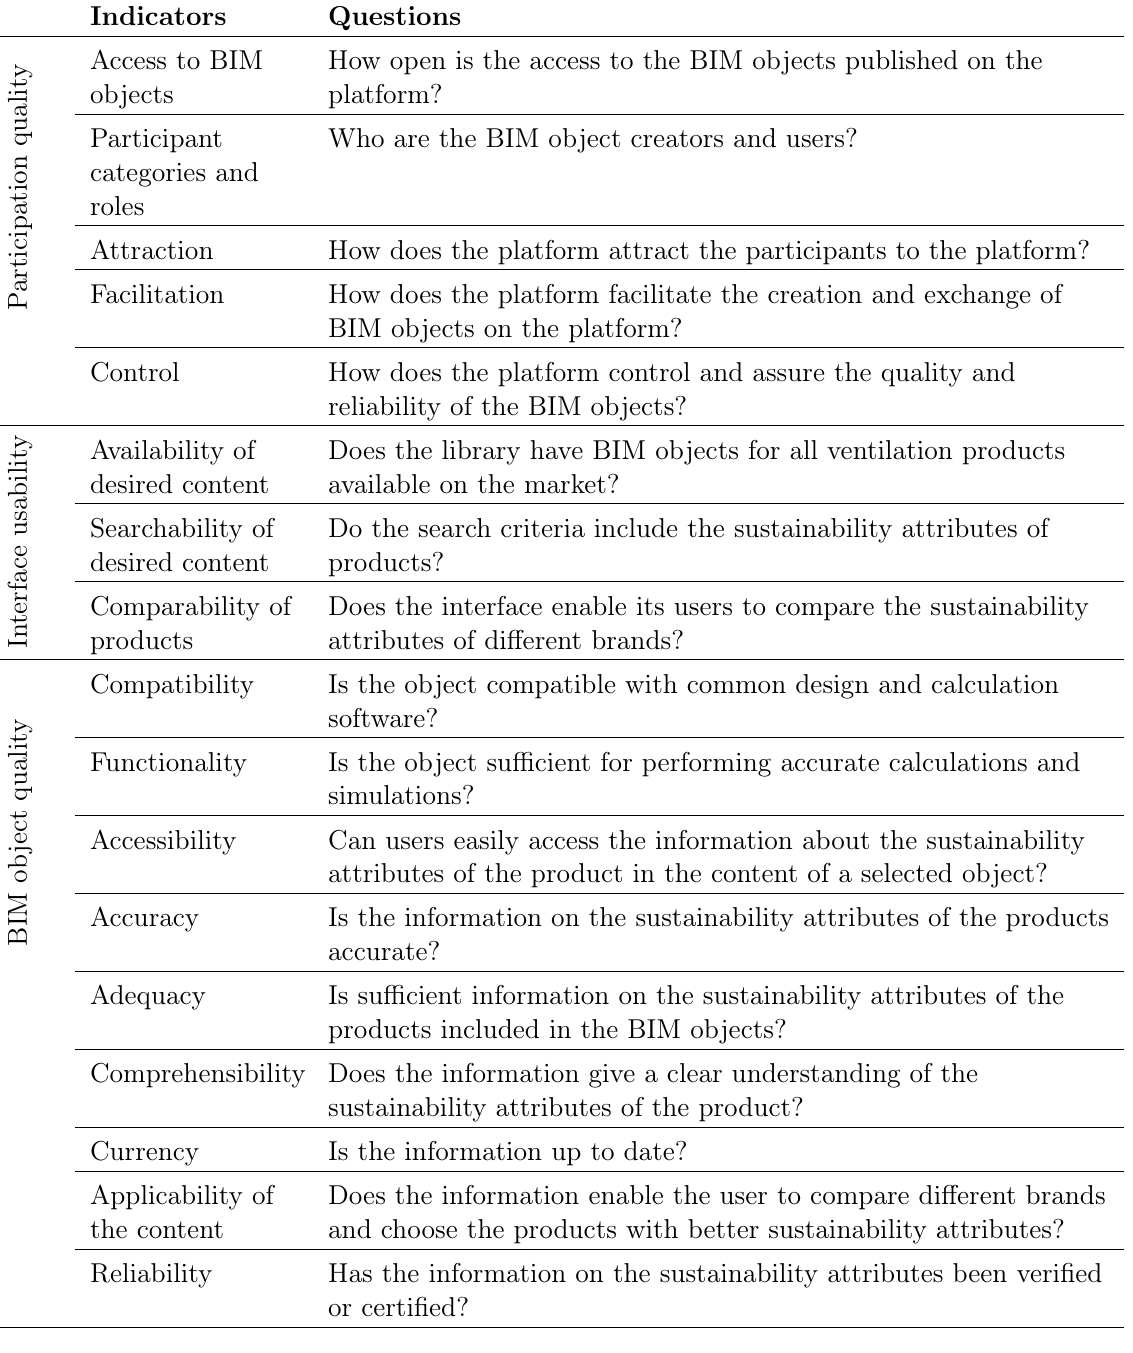
Table 2. Questions for data collection and analysis